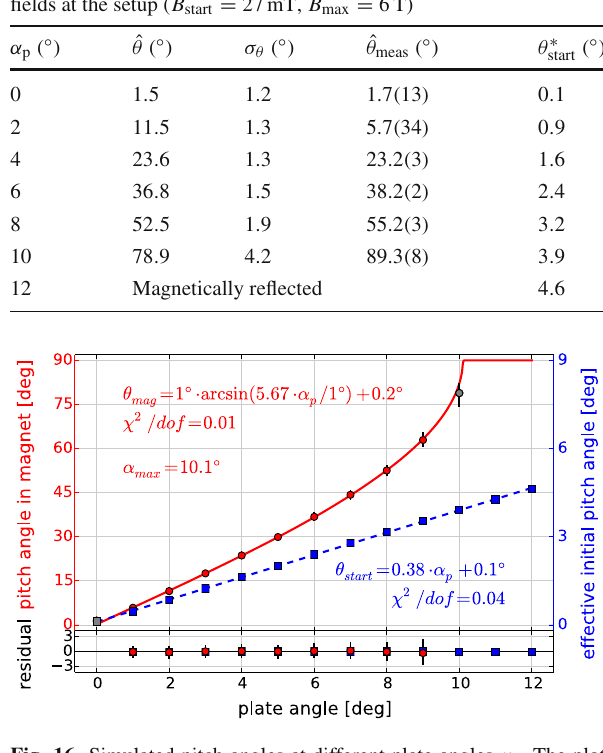
Fig. 16 Simulated pitch angles at different plate angles α p . The plot shows the produced pitch angle in the spectrometer entrance mag- net and the effective initial pitch angle at the photocathode, which is derived according to (21). The pitch angle in the magnet shows the expected arcsin-dependency on the plate angle, while the initial pitch angle depends linearly on the plate angle. Electrons are magnetically reflected at α max = 10 . 1 ◦ . The data point at α p = 10 ◦ is affected by partial magnetic reflection and shifted to lower values; it is therefore excluded from the